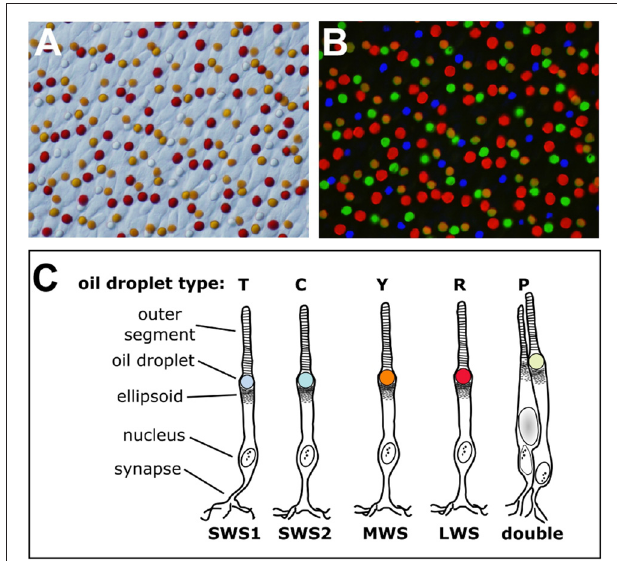
FIGURE 1 | The cone oil droplets of the vertebrate retina. (A) The cone oil droplets of the painted turtle ( Chrysemys picta ) are shown here in a bright field image of a flat-mounted retina, 400 × magnification. (B) Overlaid in this image is the same retinal field as in (A) viewed with ultraviolet (327 nm), blue (460–490 nm) and green (520–550 nm) epifluorescent illumination. Note that droplets within each cone photoreceptor subtype have distinct patterns of fluorescent excitation and emission that permit five different subtypes to be distinguished. The T-type droplets do not fluoresce because they lack carotenoid pigmentation. (C) A schematic representation of the cone photoreceptors of the chicken ( Gallus gallus ). The cone subtypes are identified by their visual pigment opsins. The nomenclature commonly used for the different oil droplet types is also indicated. This drawing is adapted from Toomey et al.